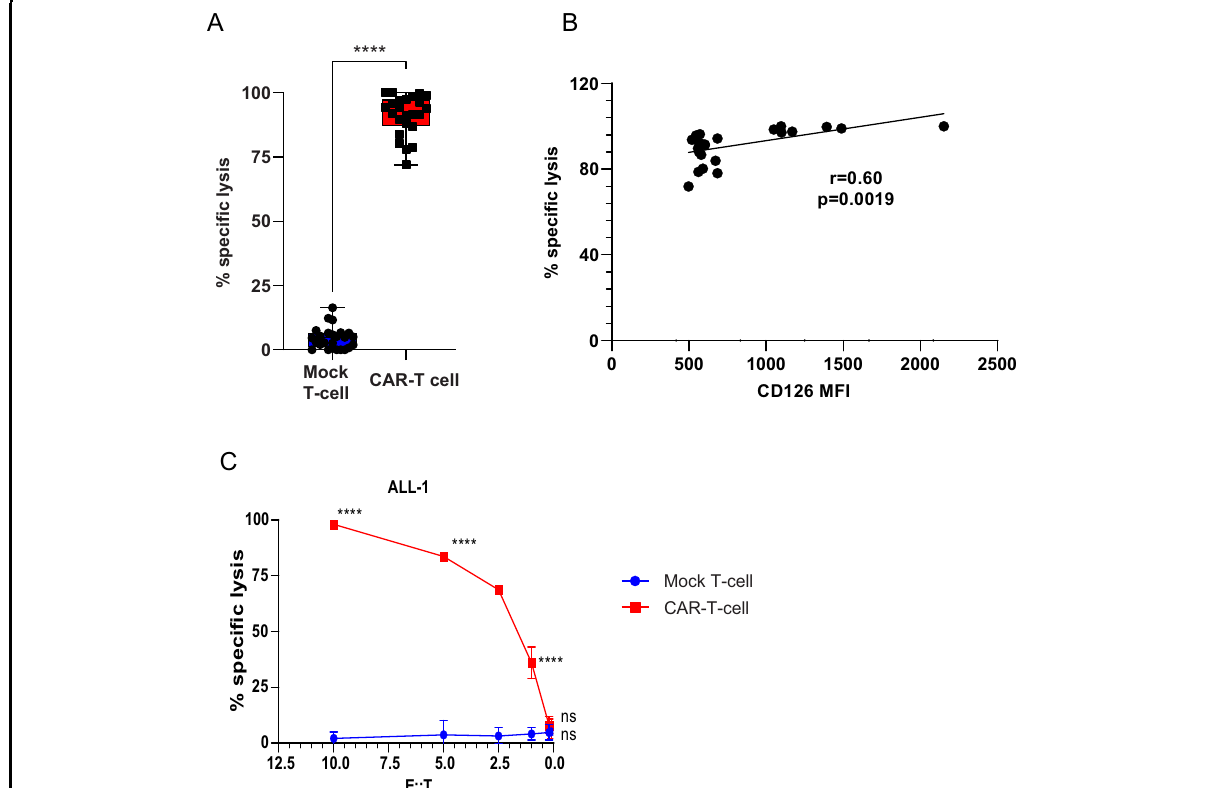
Fig. 4 CD126-targeted CAR-T cells demonstrated potent in vitro activity against primary multiple myeloma and ALL cells. a Cell killing was measured in calcein-AM-labelled MM cells when co-cultured with either CAR-T or mock T cells at effector-to-target ratio of 10 after 16 h of incubation ( n = 24 MM, 6 for each MM samples). b Lysis of target cells correlated with the level of CD126 expression. Spearman correlation coef fi cient was calculated between percentage speci fi c lysis and CD126 MFI expression on primary myeloma cells ( n = 24). c Cell killing of primary ALL cells was measured by calcein-AM-labelled cells when co-cultured with either CAR-T or mock T cell at effector-to-target ratio of 10, 5, 2.5, 1, 0.2, and 0.1 after 16 h of incubation ( n = 10). Two-way ANOVA and multiple comparison test. n.s. Non-signi fi cant. **** P < 0.0001. Each black square or circle represents a single data point from the